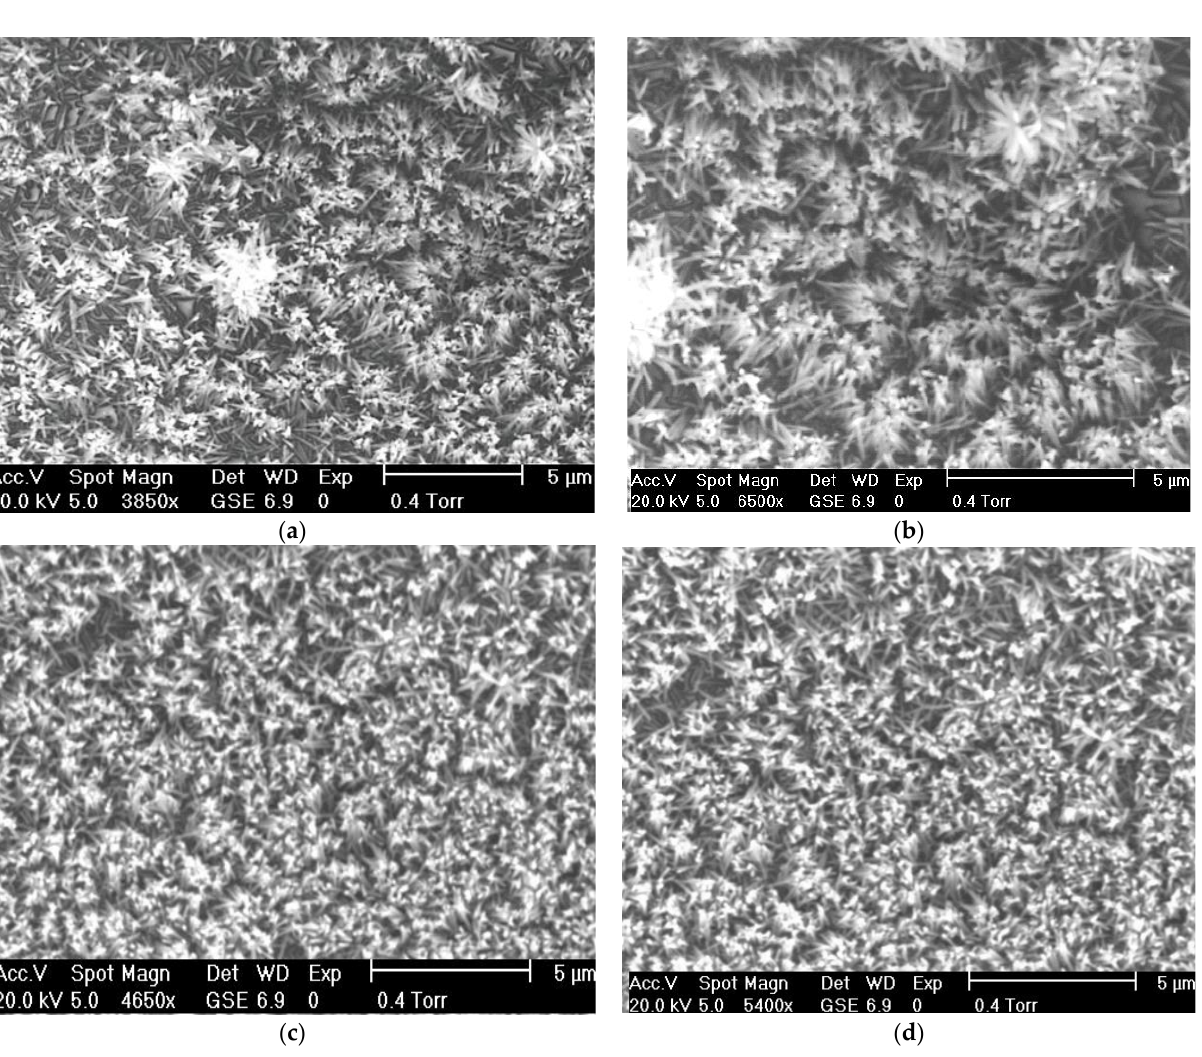
Figure 2. SEM images of ZnO nanowires, ( a ) pristine ZnO nanowires, ( b ) Li-doped ZnO nanowires, ( c ) Na-doped ZnO nanowires, and ( d ) K-doped ZnO